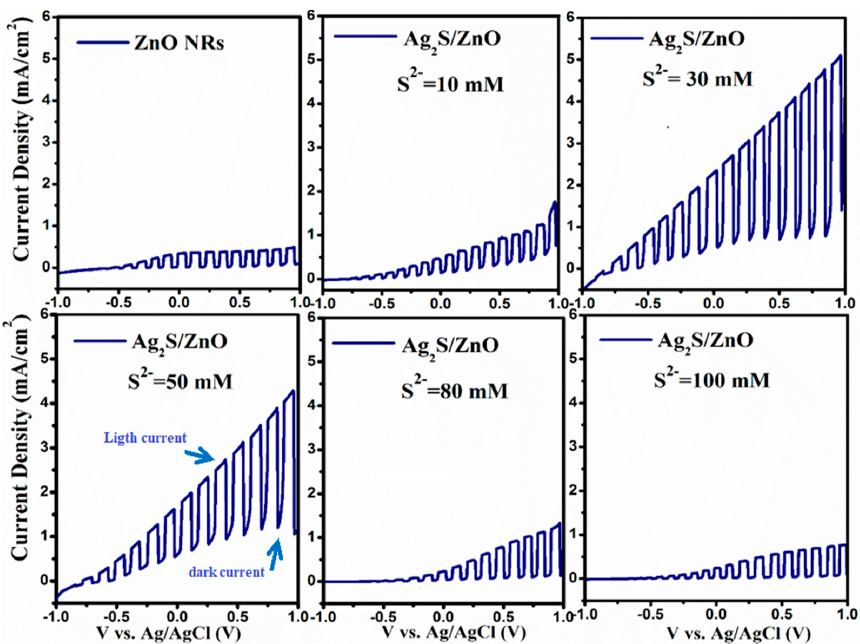
Figure 8. Linear sweep voltammograms from − 1.0 to 1.0 V at a scan rate of 20 mV s -1 for ZnO NRs/ITO and Ag 2 S/ZnO NRs/ITO formed at various CS(NH 2 ) 2 concentrations.